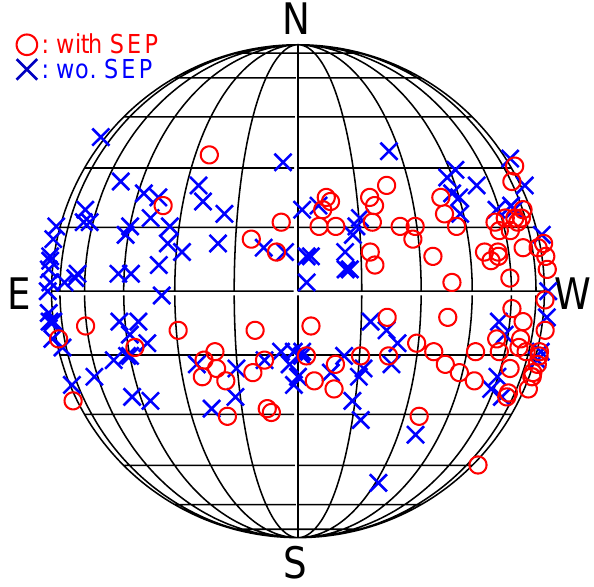
Fig. 12. Heliographic coordinates of CMEs accompanied by DH type II bursts. The circles and crosses distinguish RL CMEs with and without (wo) accompanying SEP events. All SEP events with Ip ≥ 1pfu are